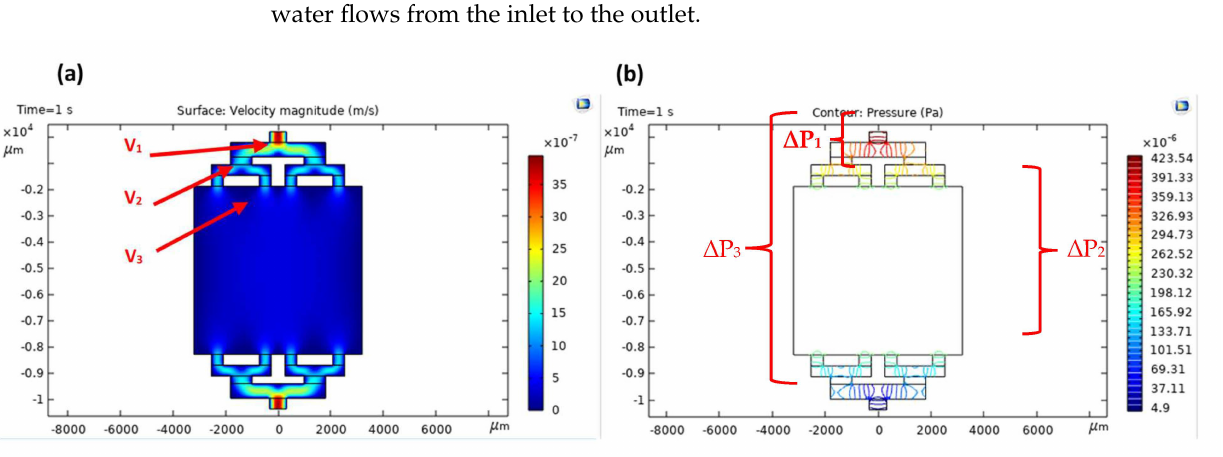
Figure 4. Velocity ( a ) and pressure ( b ) magnitude plot of the tree-branched bifurcating distributor model at a flow rate of 100 µ